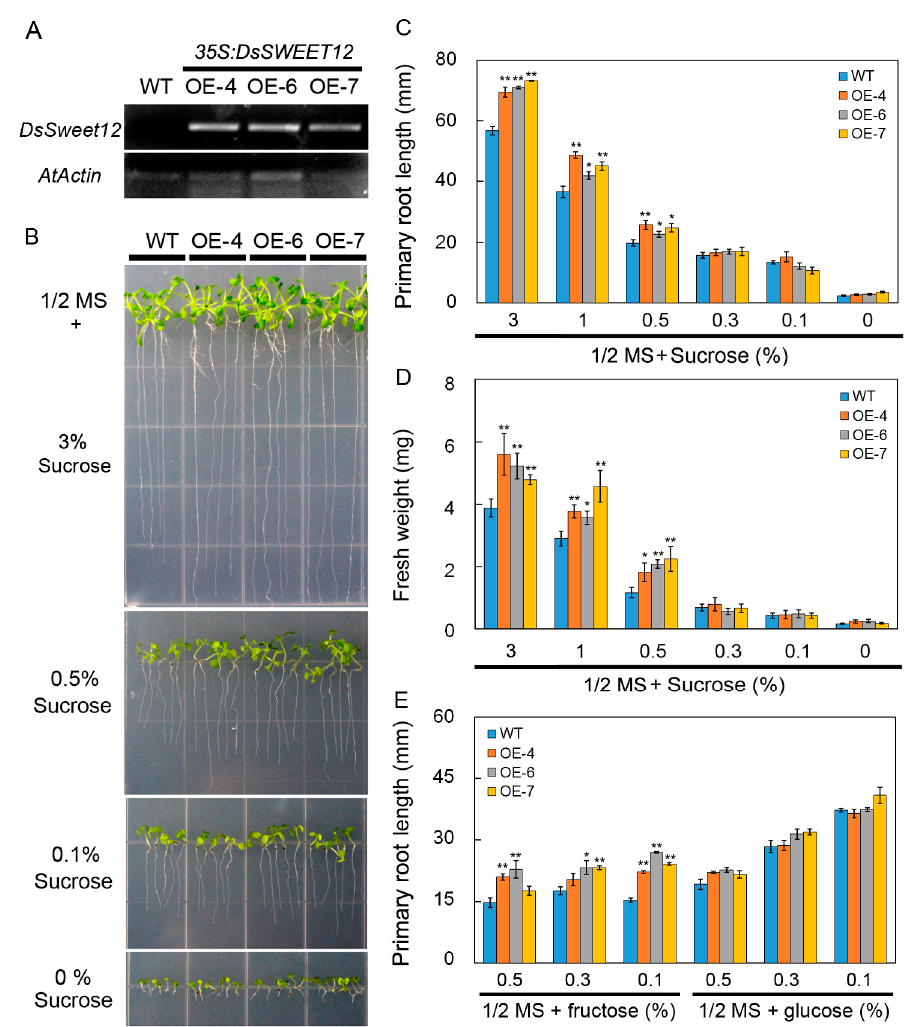
Figure 4. Growth comparison of wild type (WT) and DsSWEET12 transgenic Arabidopsis on 1/2 MS medium containing different concentrations of sugar. ( A ) Semi-quantitative PCR analysis of DsSWEET12 expression in WT and transgenic Arabidopsis lines (OE-4, OE-6, and OE-7). ( B – D ) Seedling growth ( B ), root length ( C ), and fresh weight ( D ) of WT and three transgenic lines on 1/2 MS medium (3% sucrose) containing different concentrations of sucrose. ( E ) Root length of WT and three transgenic lines on 1/2 MS (sucrose free) medium supplemented with different concentrations of fructose or glucose. Asterisks indicate significant difference between WT and transgenic lines (* p < 0.05; ** p < 0.01; Student’s t test). Error bars show the SE of the values from three replicates.